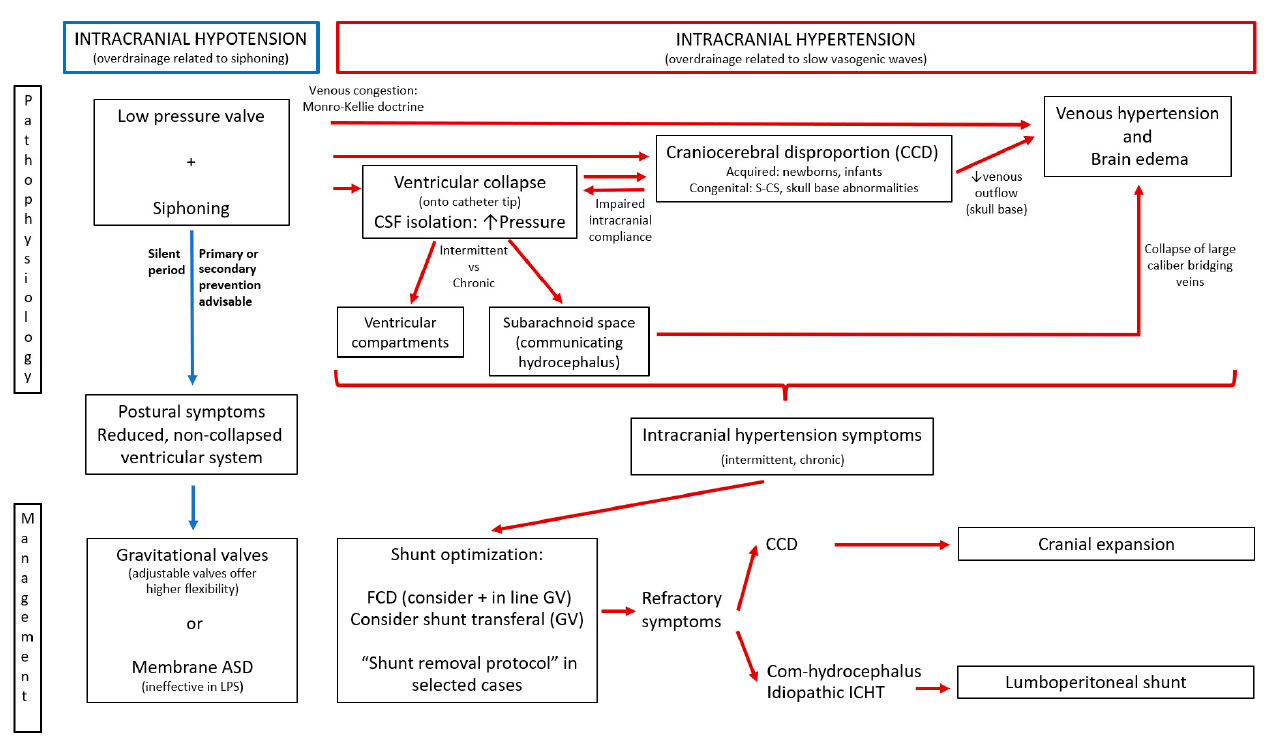
Figure 4. Shunt overdrainage syndrome. Integration of pathophysiological theories and algorithm for management. ASD: antisiphon device; FCD: flow control device; GV: gravitational valve; ICHT: intracranial hypertension.